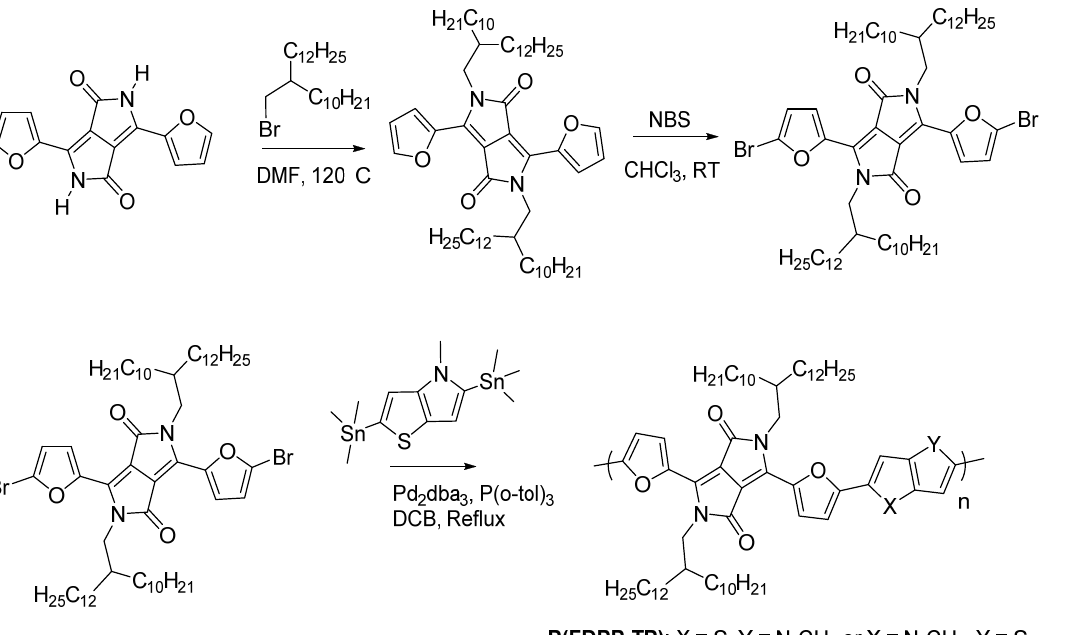
Figure 1. Structure of polymer poly(((methylthionopyrrolo)furanyl)diketopyrrolopyrrol) P(FDPP- TP)